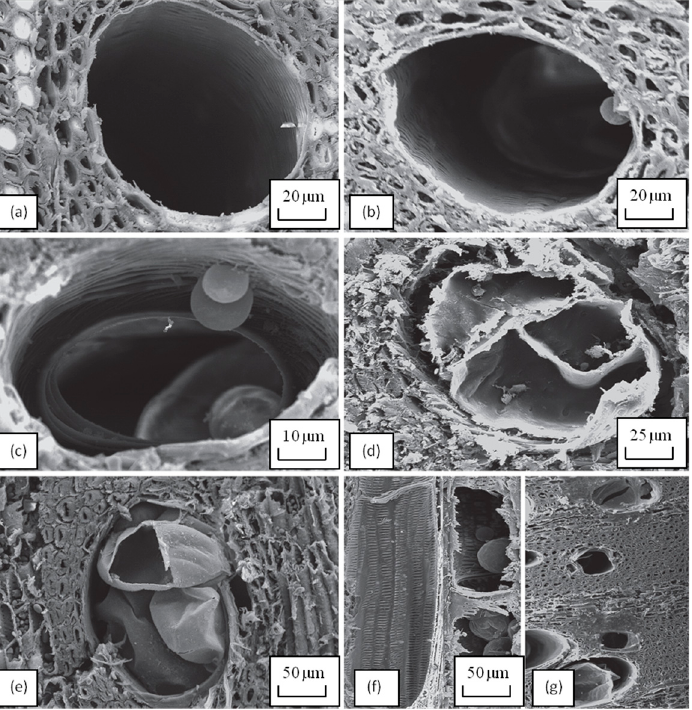
Figure 1. SEM micrographs of tylosis development in vessels of current year shoots after pruning ( a – f ). ( a ) No tylose in the vessel lumen of an unwounded control; ( b ) a small tylosis formed in the vessel lumen; ( c ) several small tyloses developed in the vessel lumen (arrows); ( d ) tyloses divided in the vessel lumen; ( e ) tyloses completely occluding the vessel; ( f ) a longitudinal section of two adjacent vessels with and without tyloses; ( g ) a vessel with gels (arrows) [29].